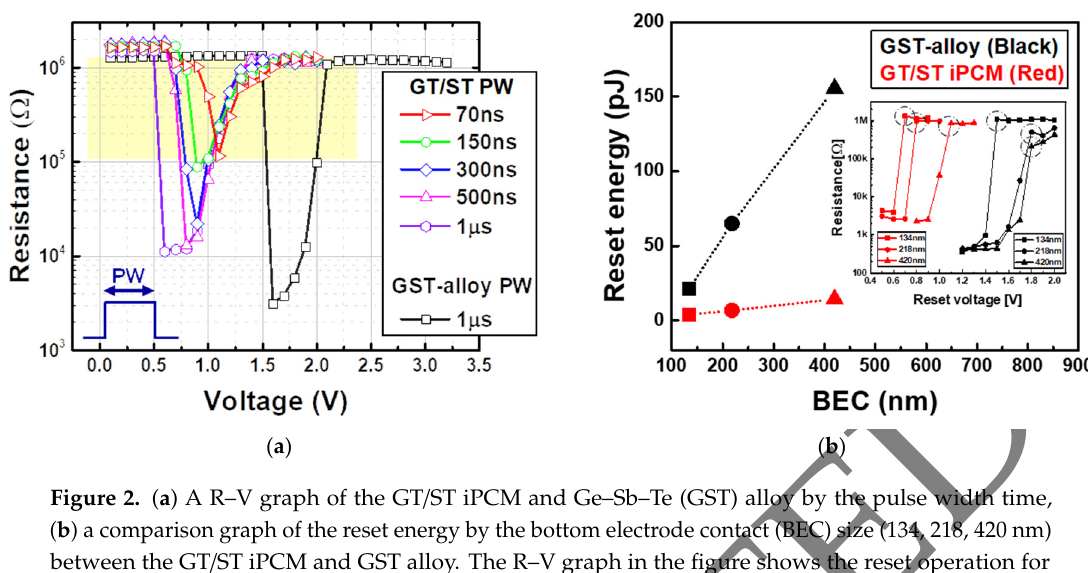
Table 1. Reduction amount of the reset energy by BEC size.